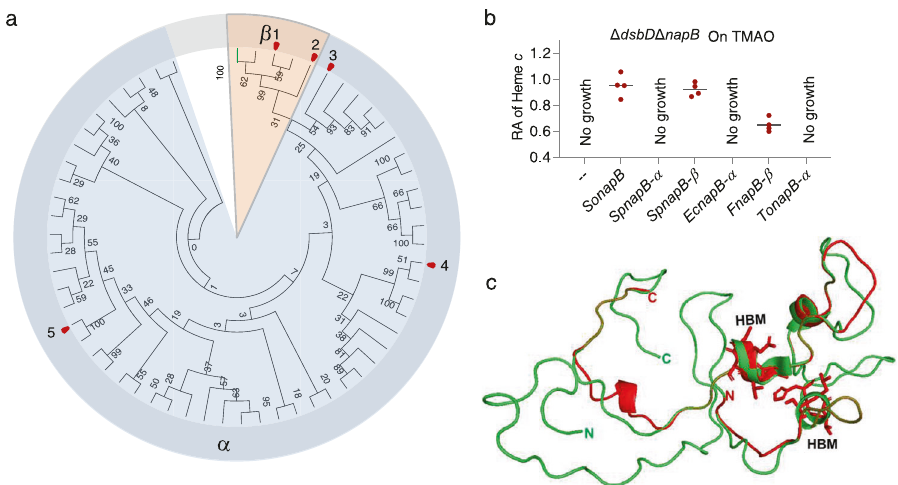
Fig. 8 Comparison of α - and β -type NapB proteins. a Phylogenetic analysis of NapB proteins. The evolutionary history was represented by the bootstrap consensus tree inferred from 1000 replicates using the Neighbor-Joining method. Bold green line represents the position of S. oneidensis NapB. Red arrows represent NapBs that were examined for their effect on cyt c biosynthesis. The tree with bacterial names was given in Supplementary Fig. 8. (1) S. piezotolerans ( β ); (2) Ferrimonas sp. S7 ( β ); 3, Thiosymbion oneisti ; 4, E. coli ; 5, S. piezotolerans ( α ). b Heme c levels in Δ dsbD Δ napB expressing one of napB s as indicated grown on TMAO to the early stationary phase. The relative abundance (RA) of heme c was obtained as described in Fig. 2b. c Structural comparison of R. sphaeroides and predicted S. oneidensis NapB proteins. Shown is a superimposition of Sp NapB (PDB id 1ogy, red) and So NapB